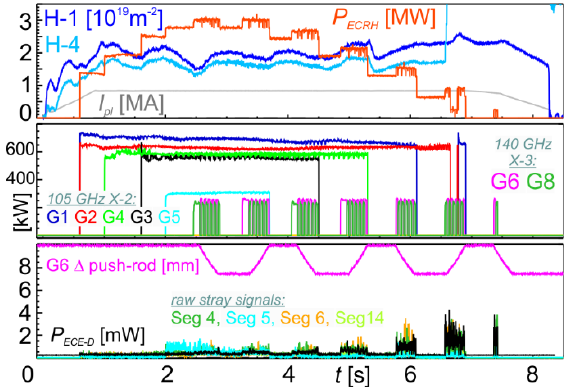
Fig. 11. Comprehensive overview of AUG discharge #39747 with total ECRH power data, evolution of plasma density and plasma current on top, individual Gyrotron power signals in the middle row, and Launcher 6 push-rod scans, as well as stray radiation signals in the bottom row. The blue density signals on top are line-integrated interferometry data. Middle row: the purpose of the group of 105 GHz Gyrotrons is to vary the plasma heating such, that different levels of plasma electron temperature exist. Bottom row: Stray radiation, in particular which is measured by the ECE, is significant only during the 140 GHz X-3 pulses and increases with decreasing plasma electron temperature, as expected.